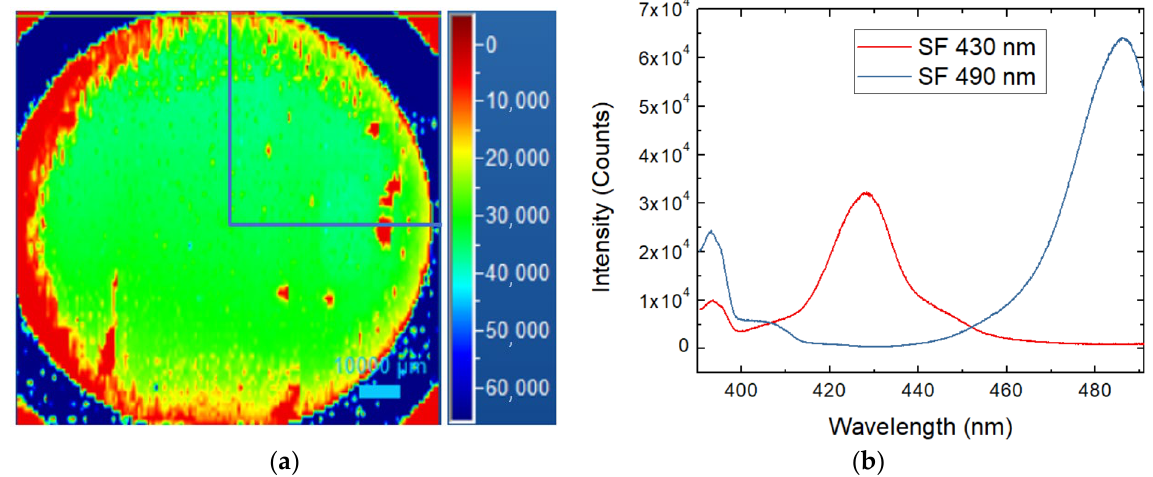
Figure 1. Photoluminescence analysis of the 4H SiC 4-inch wafer ( a ) and the common stacking fault defect on the highlighted quarter of the wafer ( b ) located mainly on the edge side.